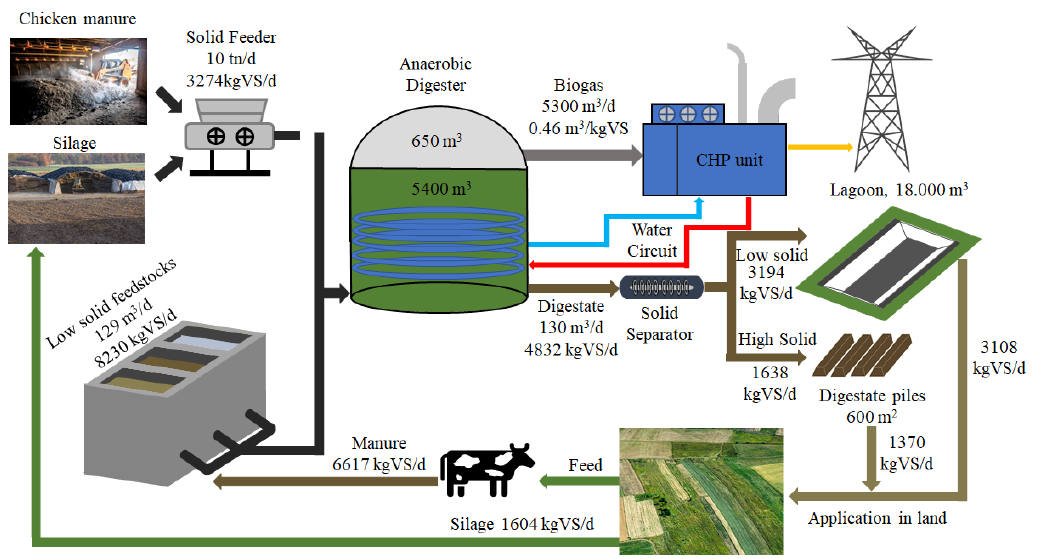
Figure 2. Layout of the full-scale biogas plant and the end uses of the final products.